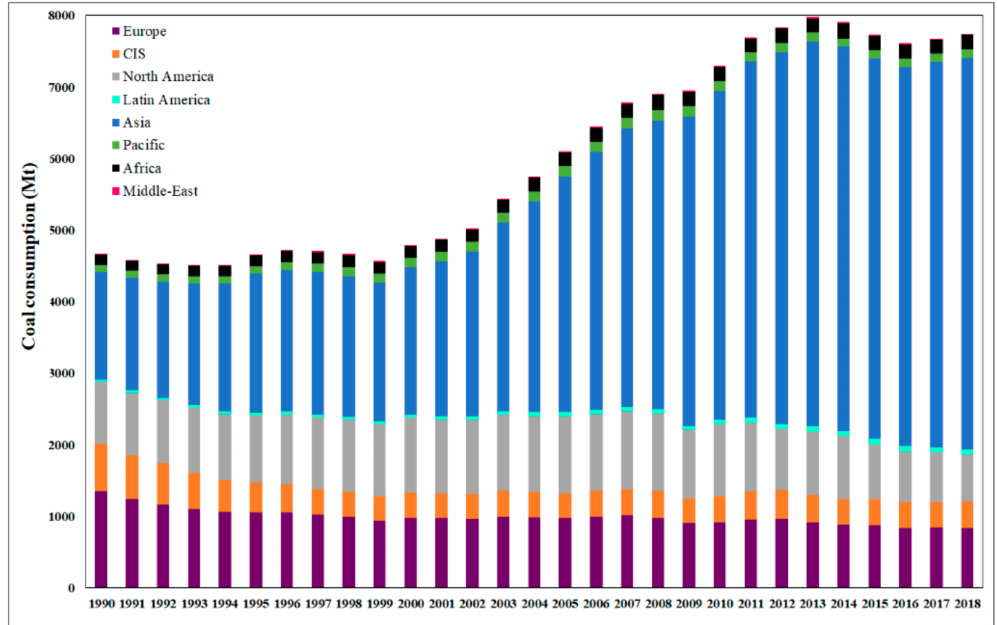
Figure 3. Global coal consumption trend (Mt) in